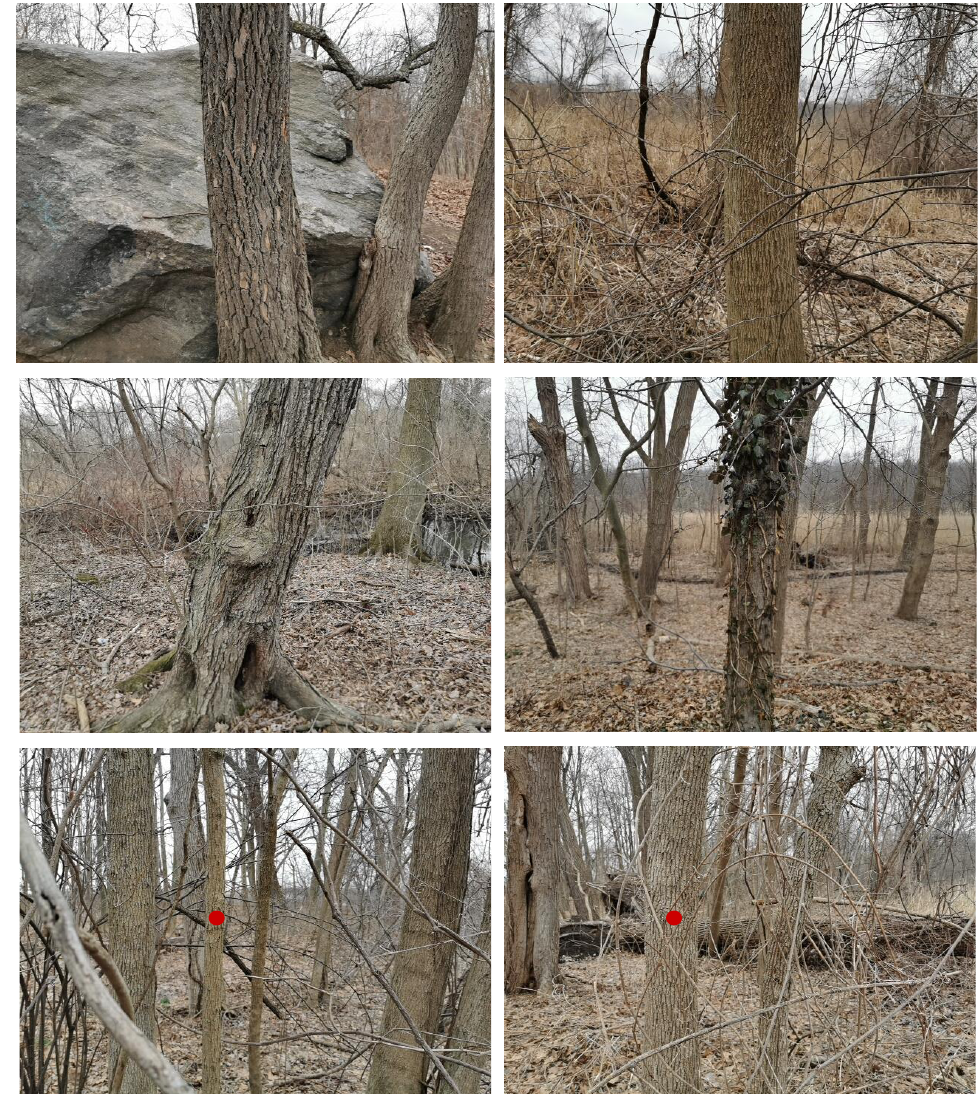
Figure A5. Sample RGB images from the Van Cortlandt data set, all of which correspond to the last (“best attempt“) image of a trunk based on user interaction. The images in the left column are categorized as “low” occlusion because they have few to no leaves or branches in front of the target trunk. The images in the right column were categorized as “medium“ or “high” occlusion. In dense areas, a red dot highlights the target trunk. These do not appear in the original